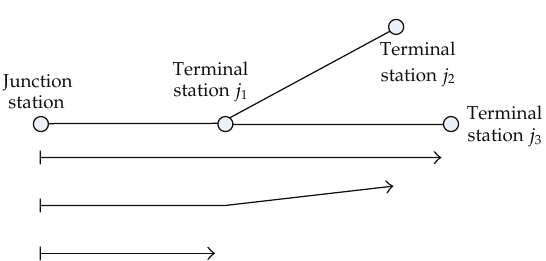
Figure 2: Through train plan from original station to di ff erent terminal stations.